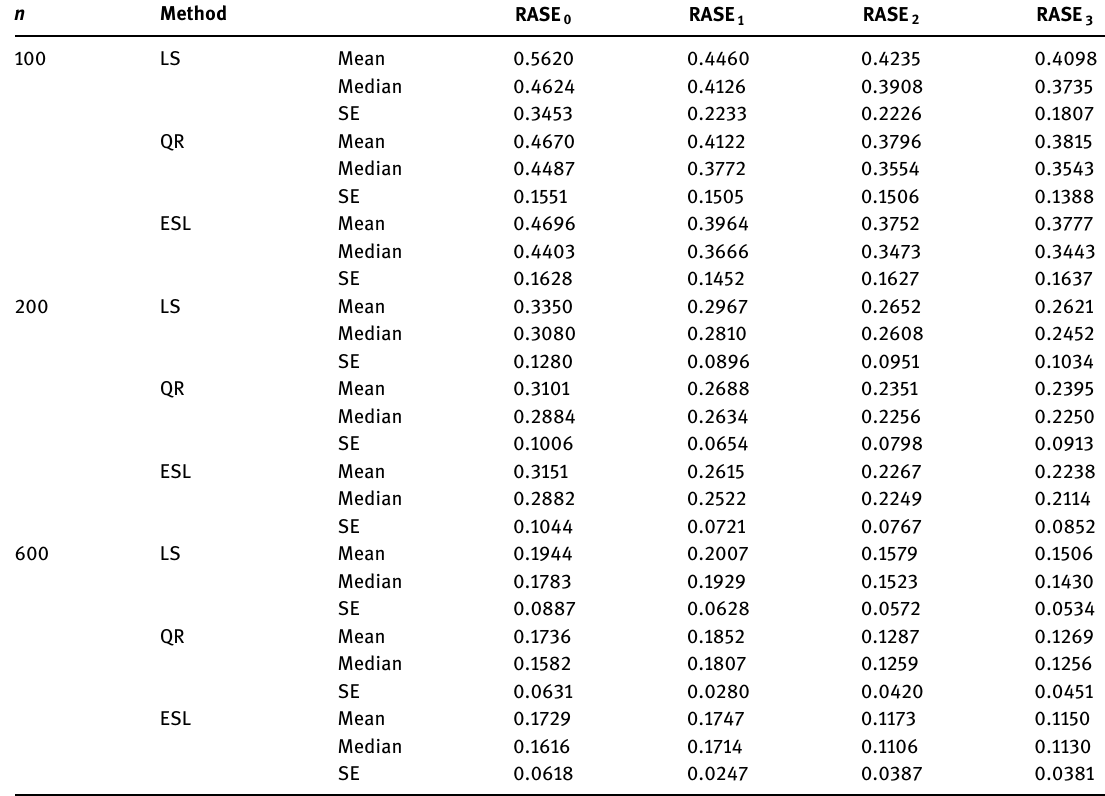
Table 2: Simulation results for comparison under ( ) t 3 error distribution when the sample size = n 100, 200, 600